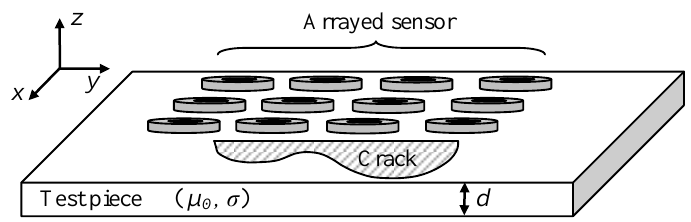
Figure 1. An arrayed eddy current sensor above a piece with a crack.